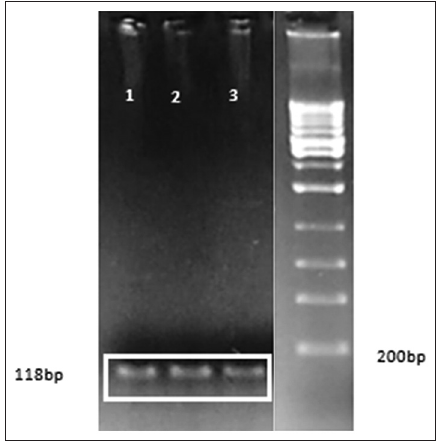
Figure-3: Gel electrophoresis of heat shock protein ( HSP)70-2 polymerase chain reaction (PCR) products. Samples 1 to 3: DNA template (HSP70 gene) from Madura sperm DNA samples. DNA samples were mixed with a 25- µ L PCR treatment. Only 3- µ L PCR products were conducted on 1× TBE agarose gel in the electrophoresis device (Hoefer) at 60 V for 35 min. Observations were made with UV light with the GelDoc Quantity One program. Source: Rosyada et al. , unpublished